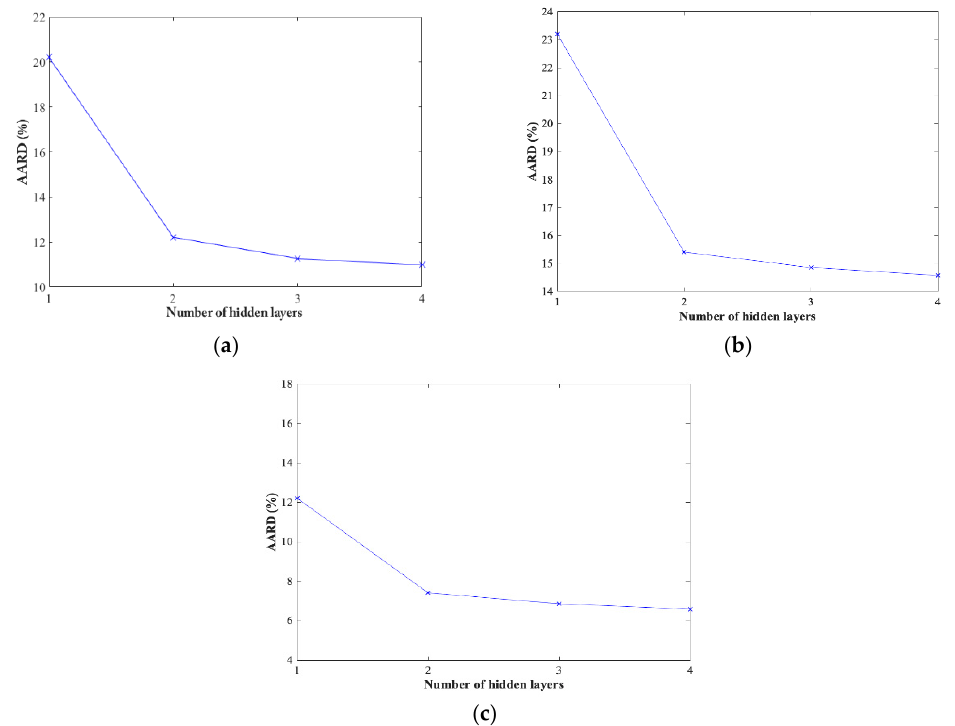
Figure 8. Effect of hidden layer number on prediction performance: ( a ) error curve of water saturation; ( b ) error curve of pressure; ( c ) error curve of oil rate.